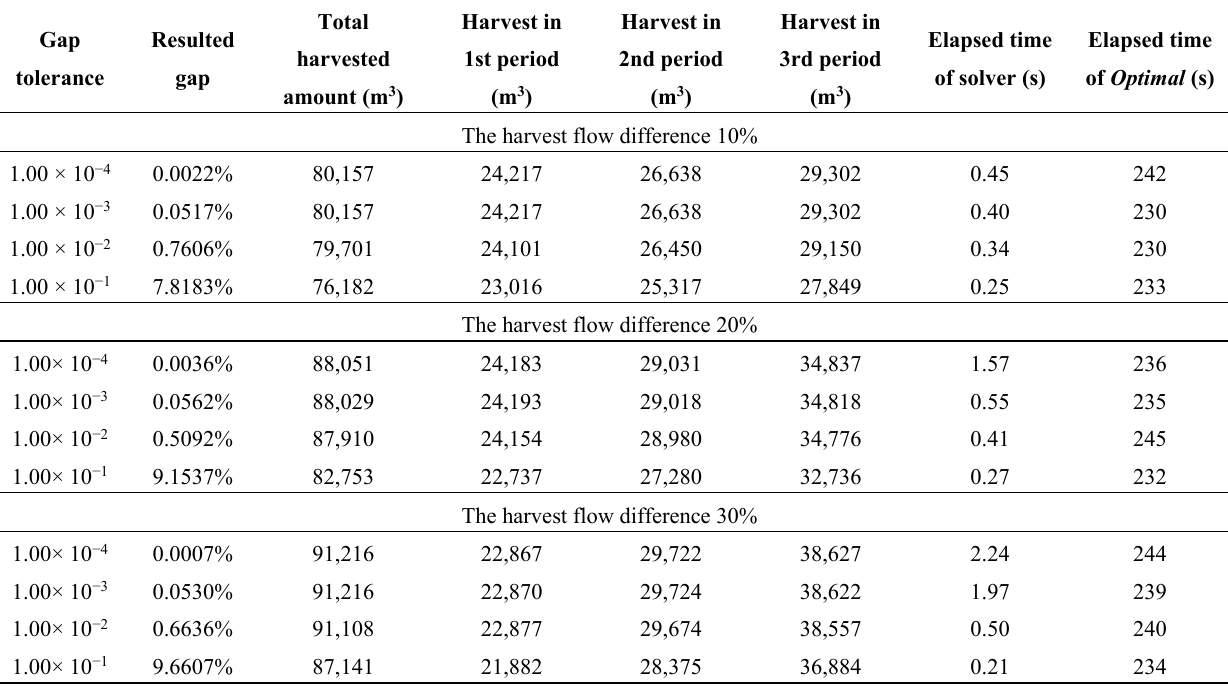
Table 2. The harvest schedule for three planning periods for different sub-variants of ComP-M according to harvest flow and gap tolerance.